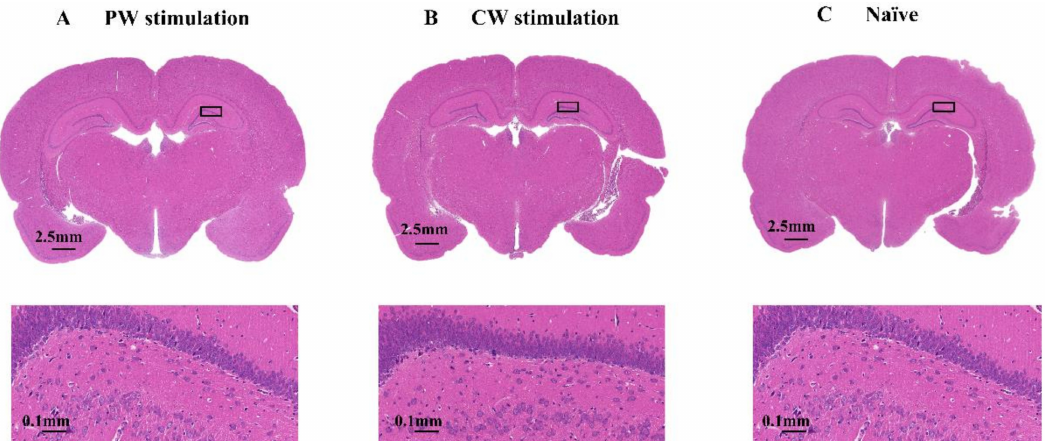
Figure 11. Histological examination of brain injury. ( A ) The eosin staining results of the pw stimulation. ( B ) The eosin staining results of the cw stimulation. ( C ) The eosin staining results of the naïve rat. A comparison of hematoxylin and eosin staining in brain sections obtained from US-treated and naïve rats was performed. These histological results were similar for naïve (US-) and US-treated brain sections (cw stimulation and pw stimulation). The large rectangles show a higher magnification of the hippocampus